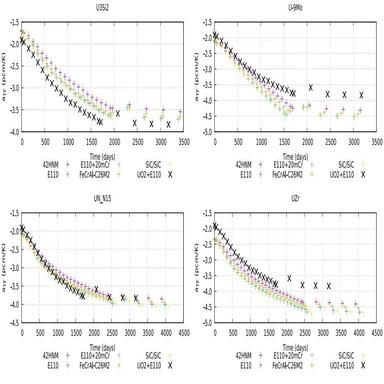
Fuel temperature reactivity feedbacks of chosen fuel-cladding combinations.